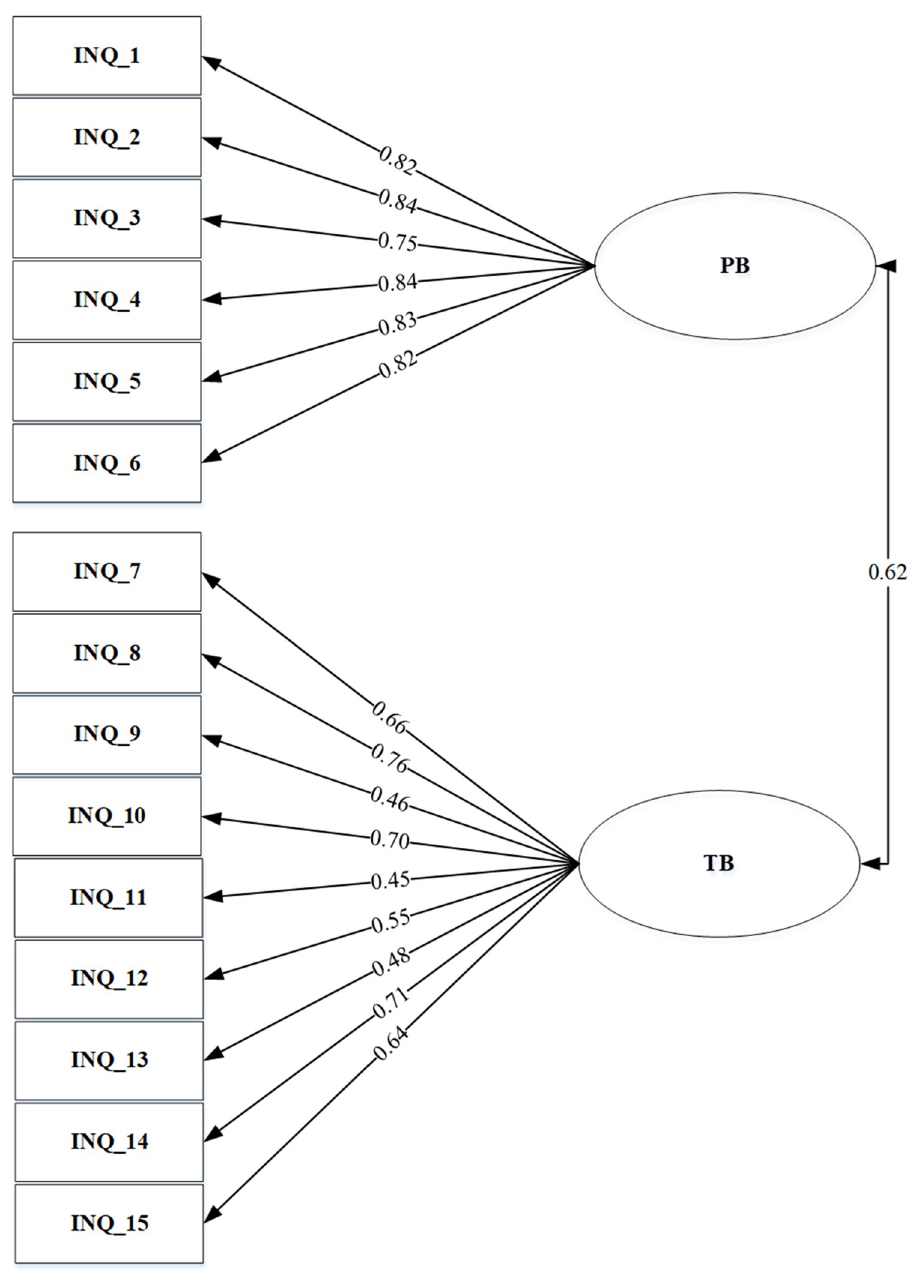
Fig 2. Two factors model.